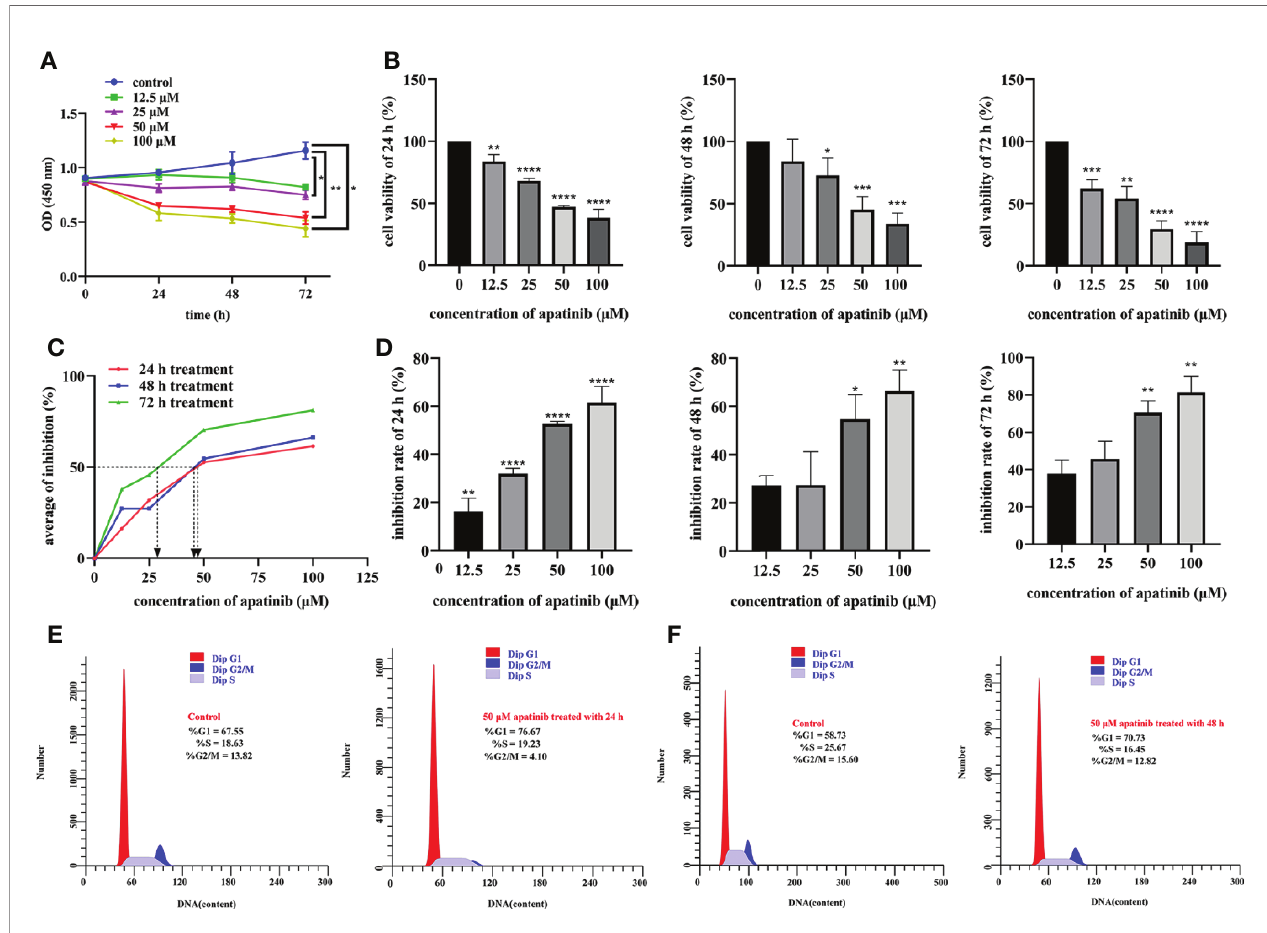
FIGURE 2 | Apatinib inhibits proliferation and affects cell cycle of malignant peritoneal mesothelioma (MPM) cells. (A) The biological effects of apatinib on the proliferation of MPM cells (incubated with apatinib at the increasing concentrations from 0 m M to 100 m M for 24, 48, and 72 h, respectively). (B) The viability of MPM cells was stymied by the speci fi ed concentration of apatinib treated for 24, 48, and 72 h, respectively. The cytotoxicity of apatinib on MPM cells was con fi rmed by CCK-8 assays. (C) The IC 50 values of apatinib in MPM cells after 24, 48, and 72 h of treatment. (D) The inhibition rate of apatinib on MPM cells for different time (* P < 0.05; ** P < 0.01; *** P < 0.001; **** P < 0.0001). (E, F) Cell cycles in MPM cells were determined by fl ow cytometry after apatinib treatment for 24 h and 48 h, respectively.